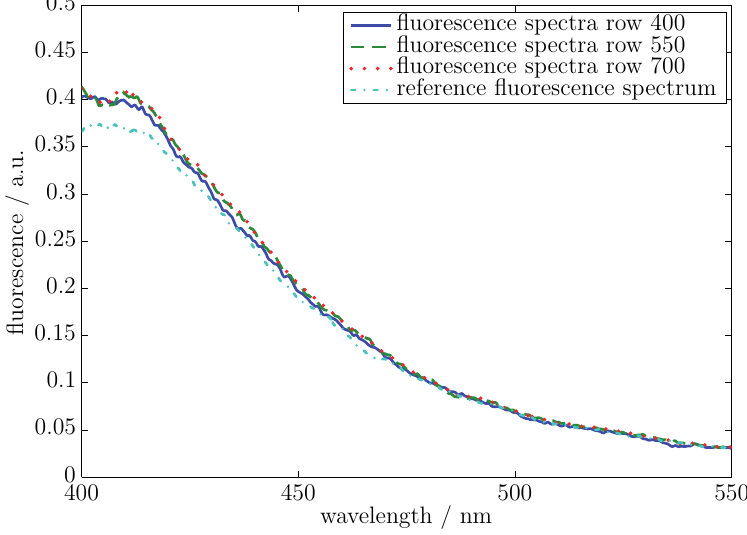
Figure 4. Static measured hyperspectral fluorescence spectra of a viscous material without an impurity. Exemplarily, spectra of rows 400, 550 and 700 and a reference spectrum of a UV-Vis-spectrometer are illustrated. The location of the three rows is on both sides and in the middle of the relevant area on the CMOS 2D sensor array. The intensities of all fluorescence spectra are specified in arbitrary units